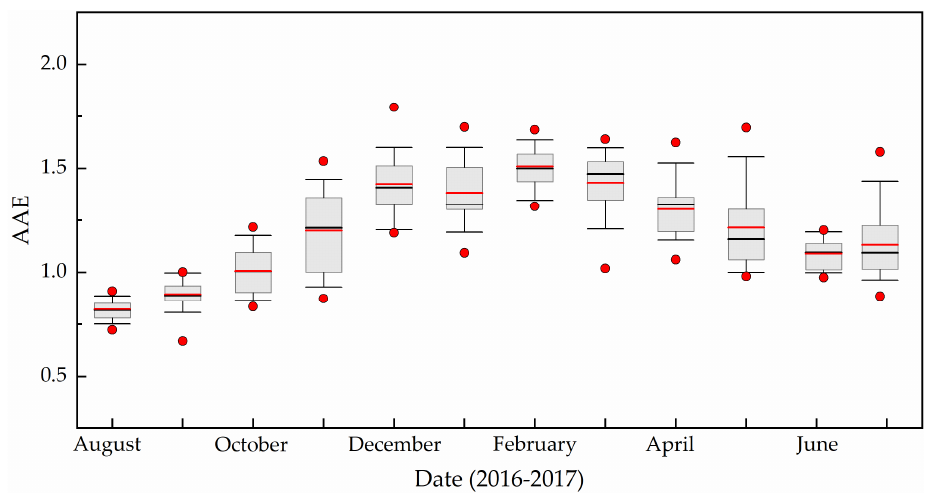
Figure 6. Monthly variation of AAE during the study period.